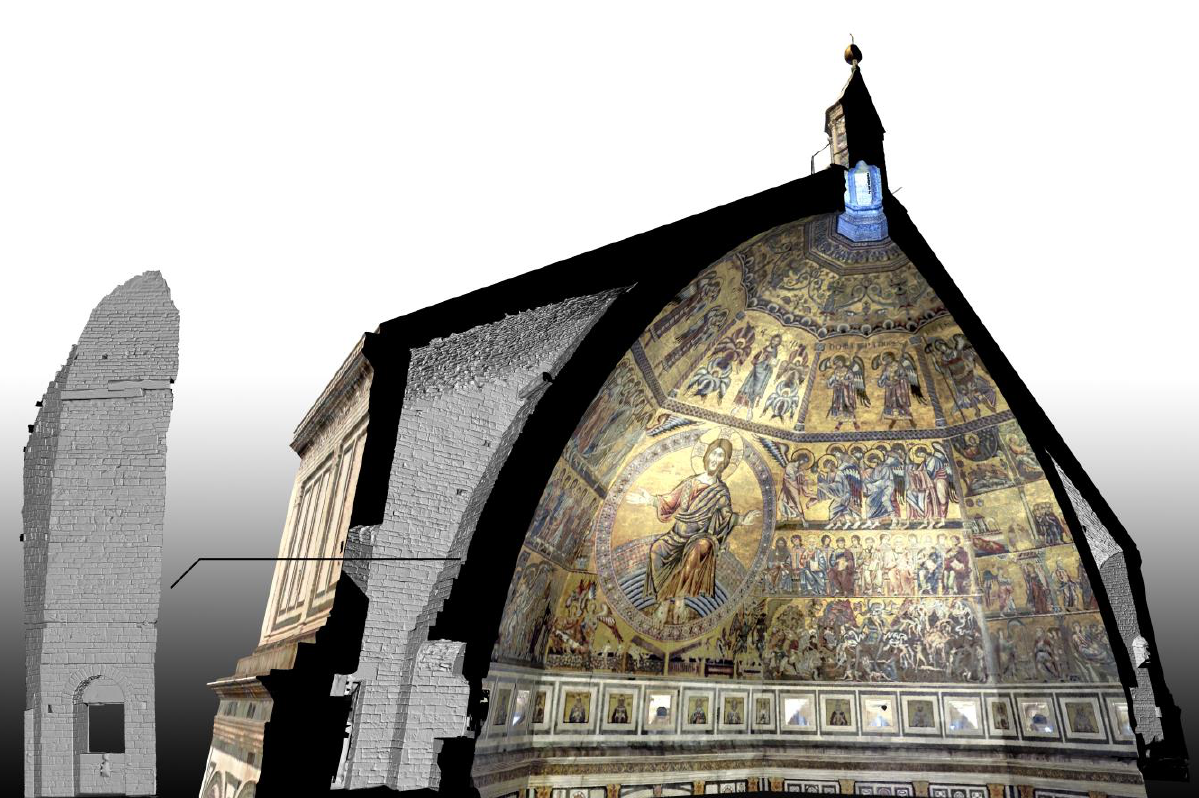
Figure 5. 3D section of the